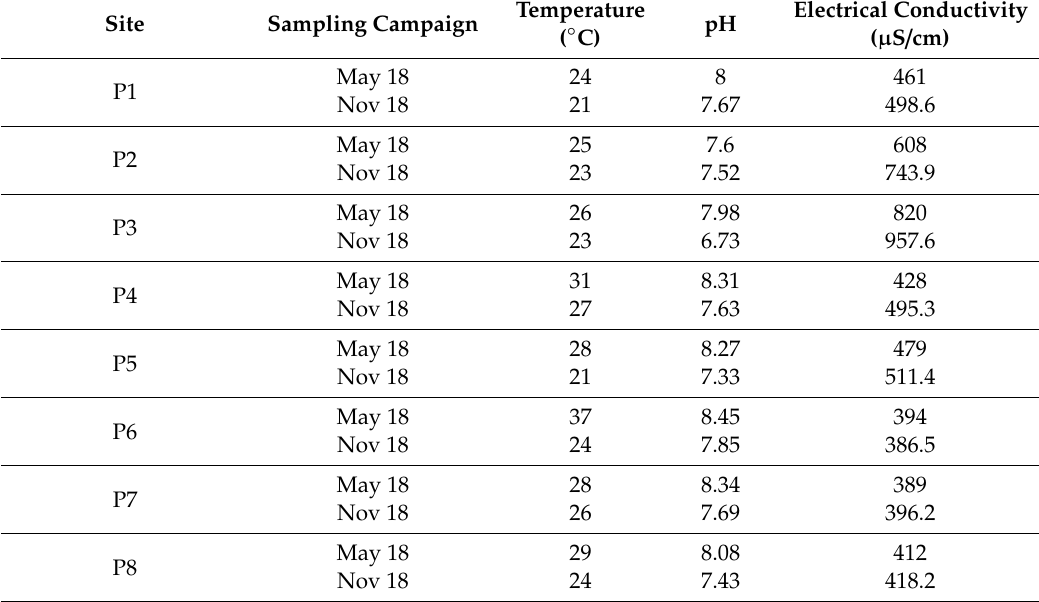
Table 6. Results of the parameters measured in situ in two sampling